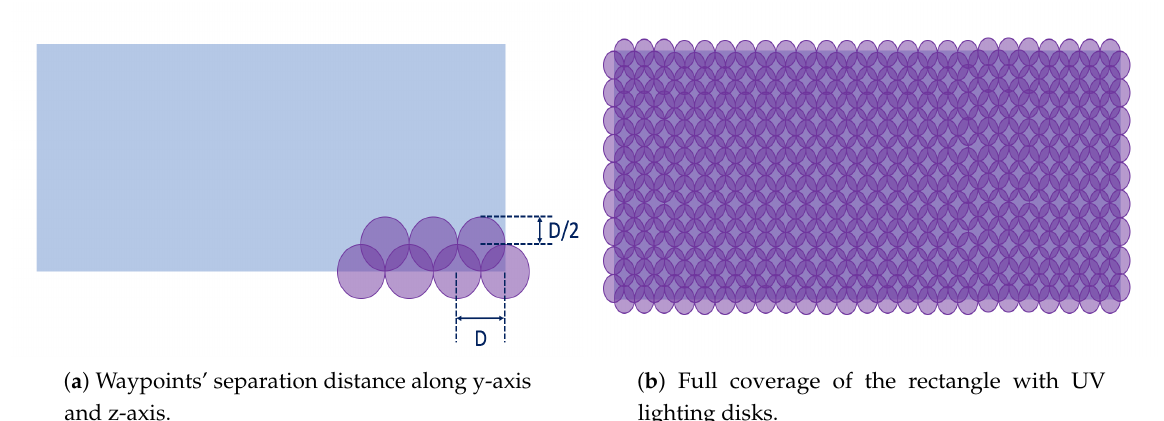
Figure 4. NDT simulated inspection.